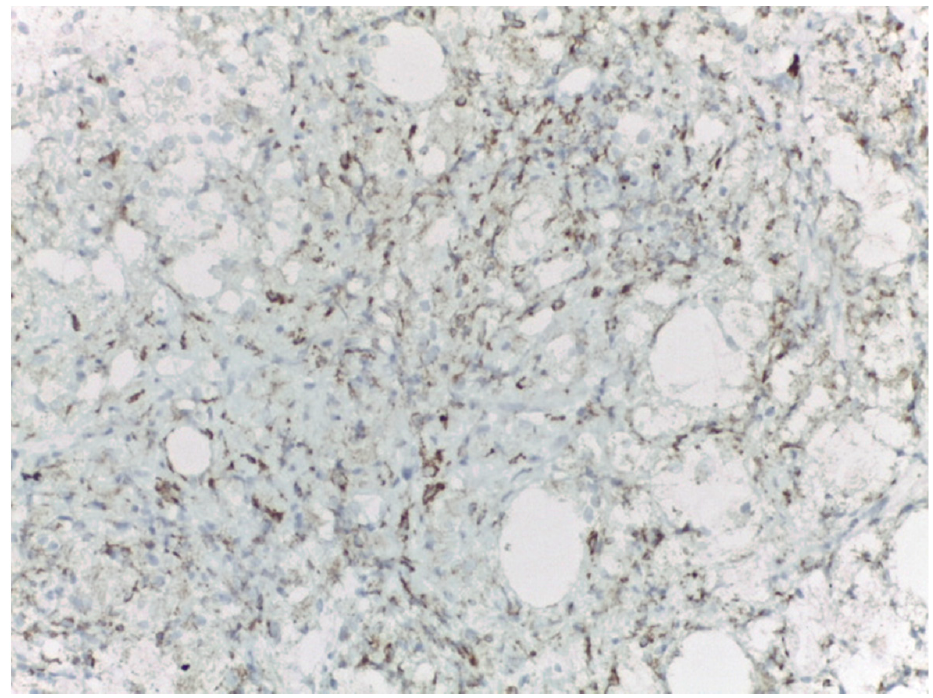
Figure 5. Rosai–Dorfman disease of the breast: immunohistochemistry—CD68 focally positive histiocytes (20 × ).